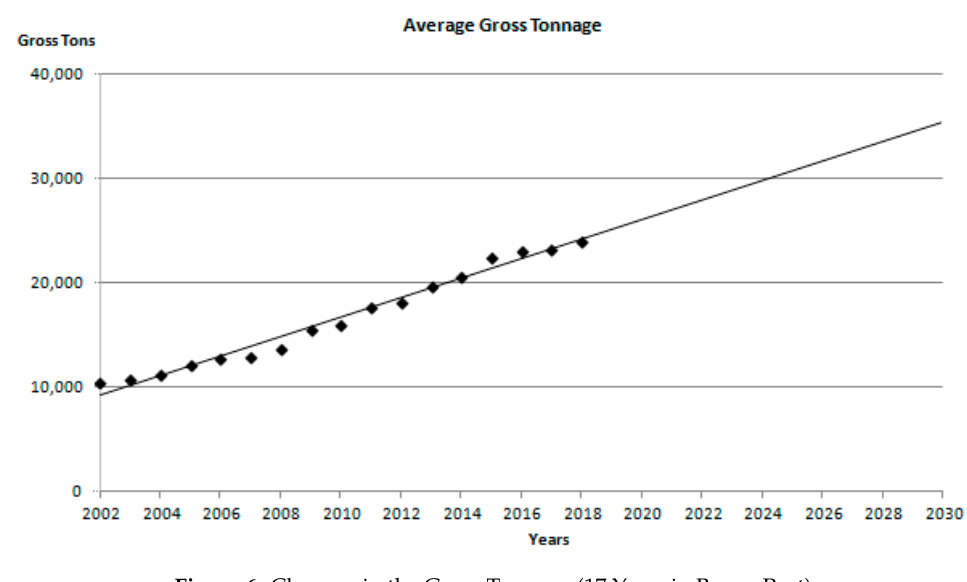
Figure 6. Changes in the Gross Tonnage (17 Years in Busan Port).